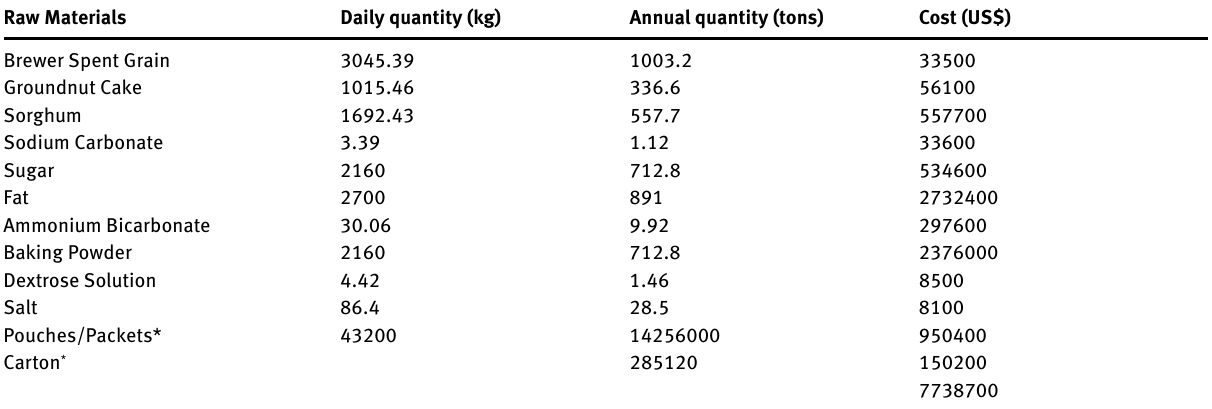
Table 2 : Annual cost of raw materials for the cookies production plant Raw Materials